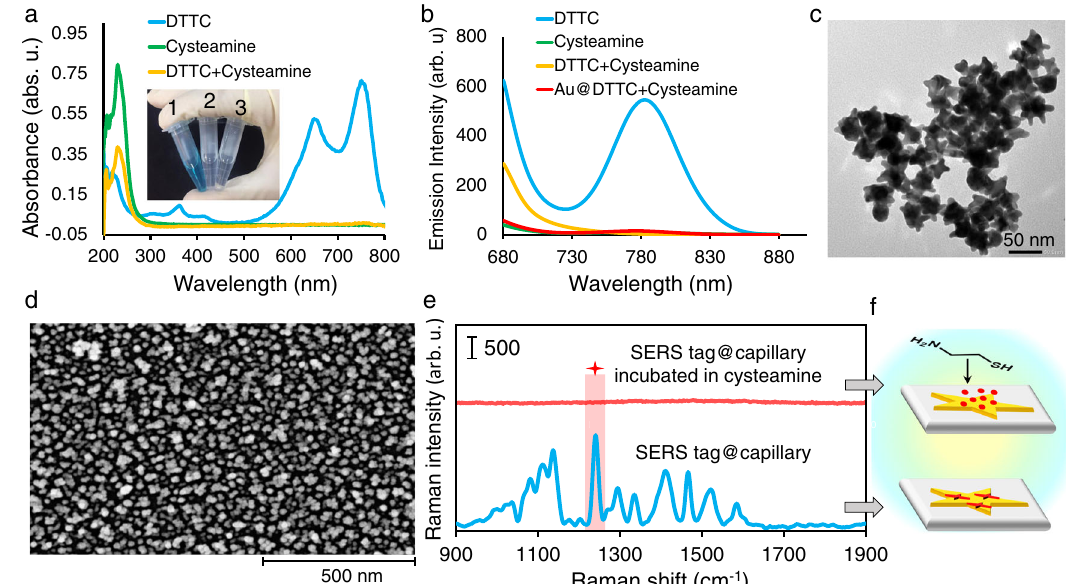
Fig. 3 | Chemical degradation of DTTC by an inspector molecule. a UV – Vis and b fl uorescence spectraof the reactants and degradation products. c TEM image of Au NSs. d SEM images of Au NSs assembled on capillary glass. e Raman spectra of